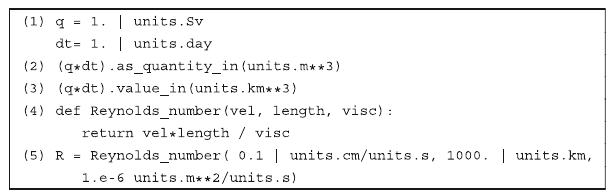
Figure 3. An illustration of the use of the OMUSE unit algebra module, with (1) a definition of a scalar quantity using the | opera- tor, (2) conversion of a quantity to different units, (3) conversion of quantity to float, and (4 and 5) definition of a function and its call using